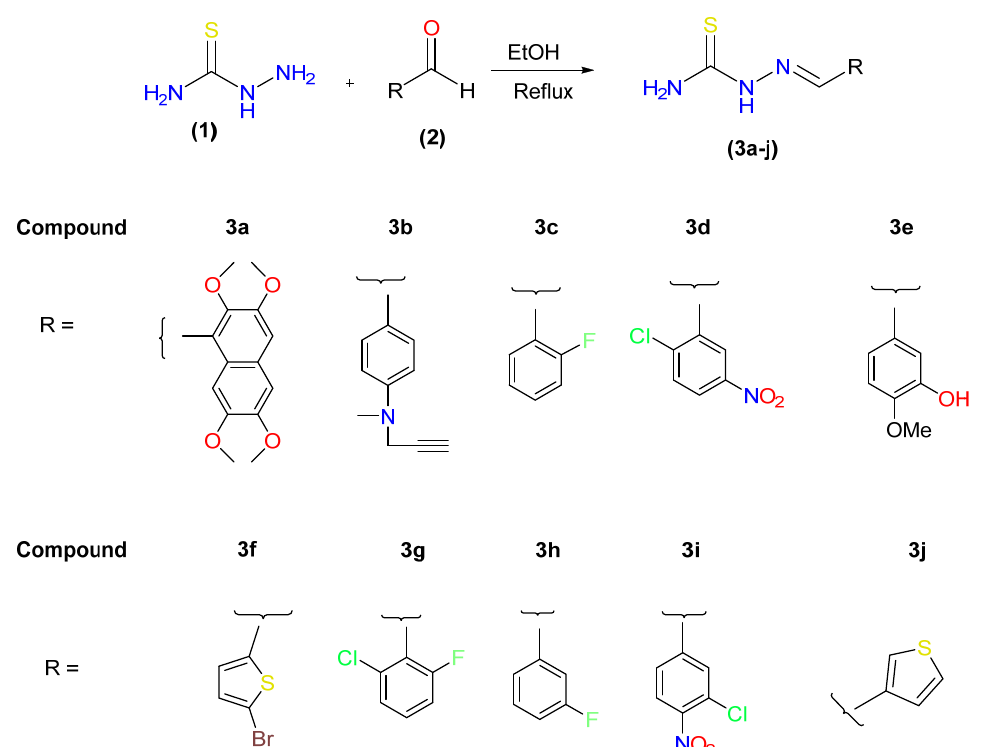
Figure 2. Synthesis of 2-(aryl/heteroaryl)methylene) hydrazine-1-carbothioamides ( 3a – j